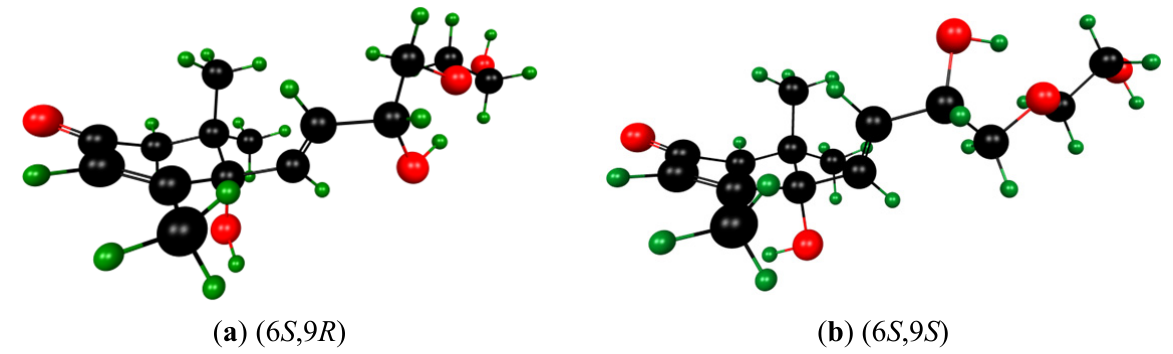
Figure 4. Conformations for compound 3 , ( a ) or ( b